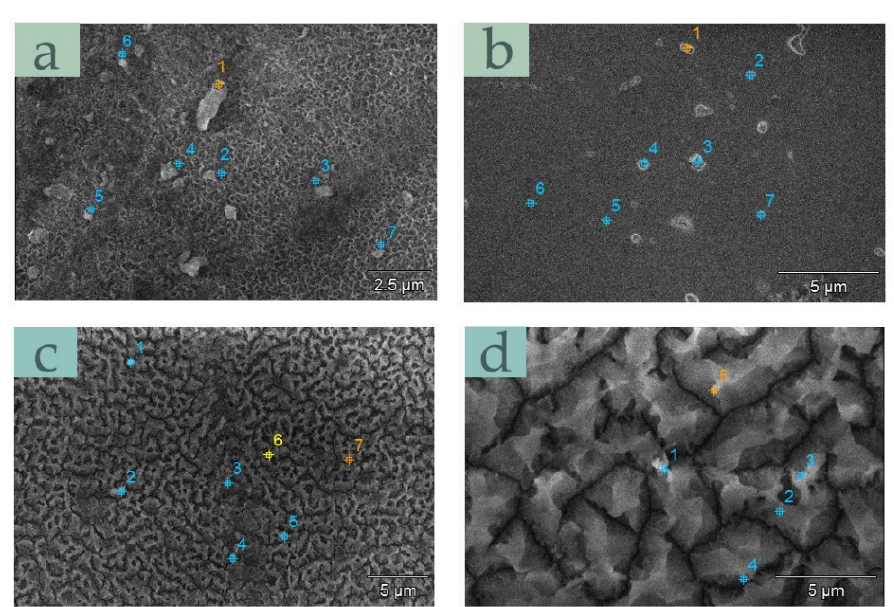
Figure 3. EDX map of anodic layer.